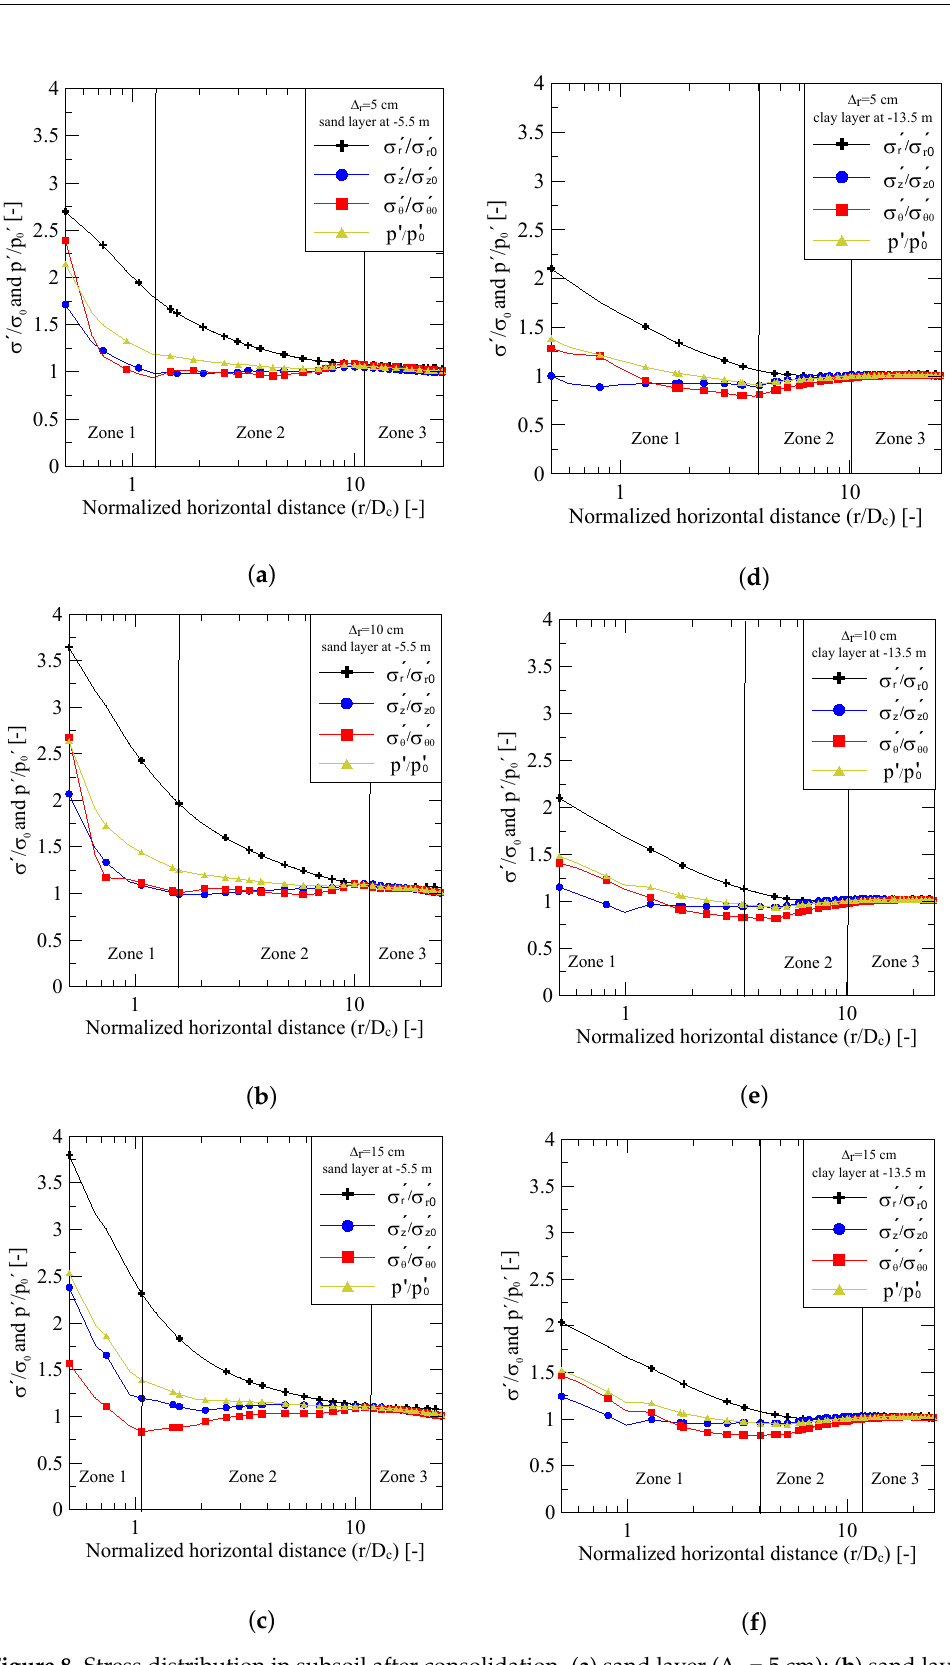
Figure 8. Stress distribution in subsoil after consolidation. ( a ) sand layer ( ∆ r = 5 cm); ( b ) sand layer ( ∆ r = 10 cm); ( c ) sand layer ( ∆ r = 15 cm); ( d ) clay layer ( ∆ r = 5 cm); ( e ) clay layer ( ∆ r = 10 cm); ( f ) clay layer ( ∆ r = 15